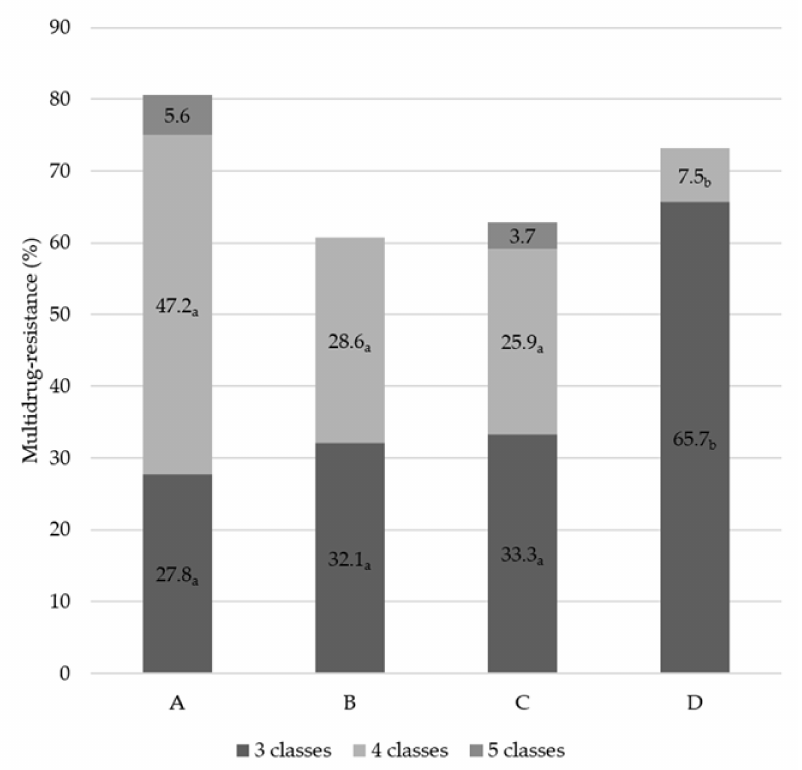
Figure 1. Distribution of multidrug resistance of 185 high-level aminoglycoside-resistant Enterococcus faecalis isolated from the bulk tank milk of four dairy companies. Values without the same subscript letter ( a,b ) differ significantly ( p <